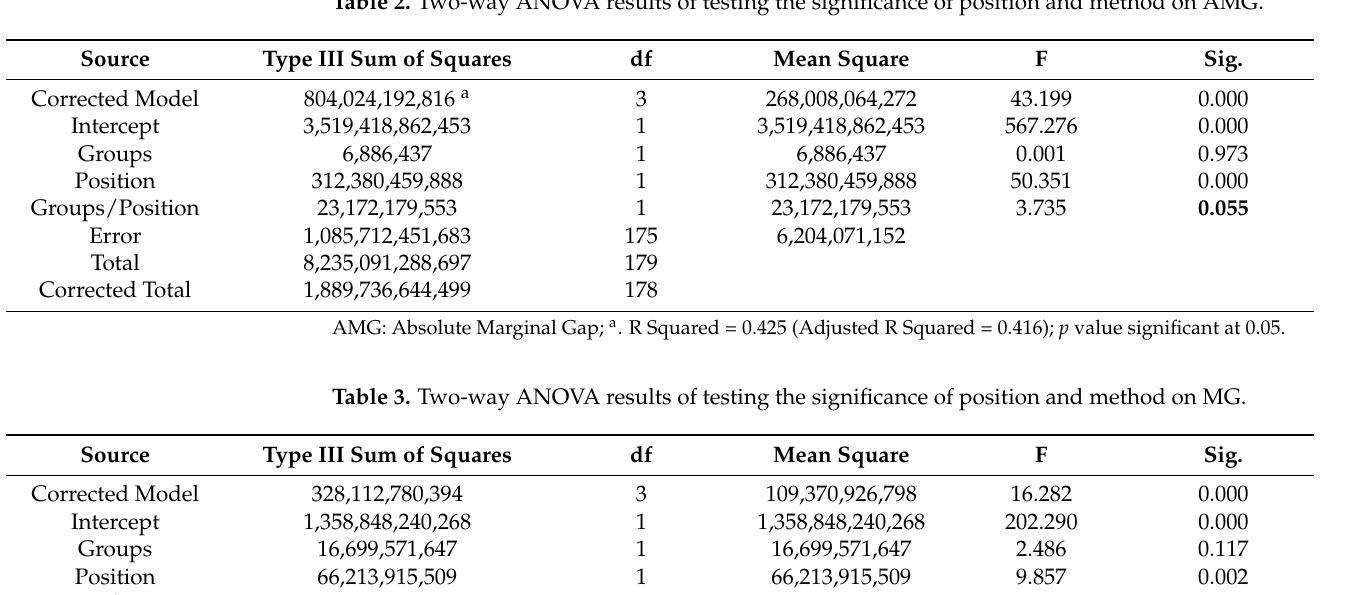
Table 2. Two-way ANOVA results of testing the significance of position and method on AMG.